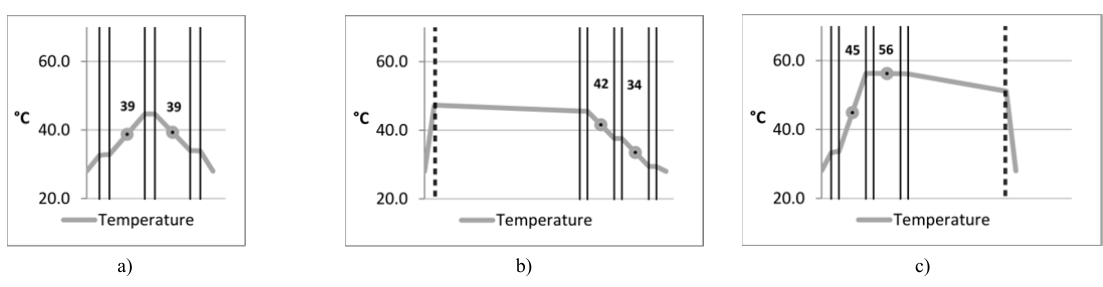
Fig. 4 TGU according to TRLV climate as a) single TGU, b) with black non transparent external sunscreen and c) with black non transparent, non-ventilated internal glare shield